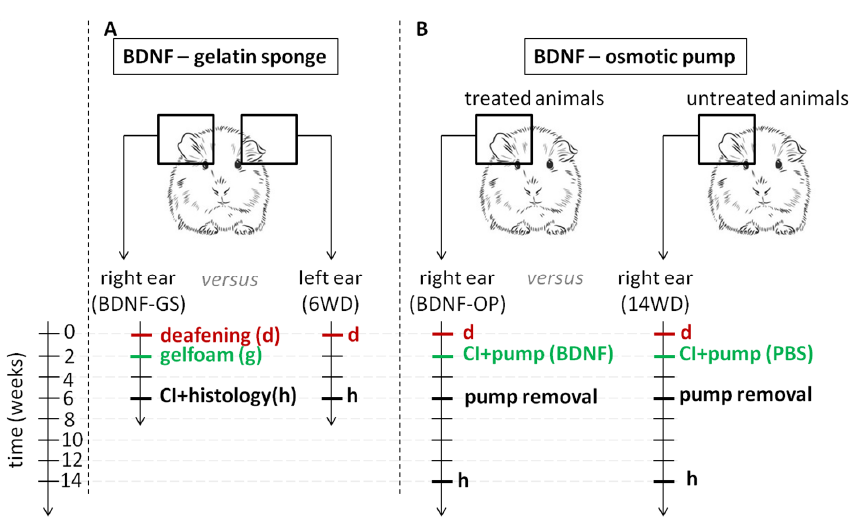
Figure 1. Schematic illustration of the experimental groups. ( A ) Study A was conducted on deafened guinea pigs which received the BDNF-gelatin sponge treatment in the right ears two weeks after deafening, while the contralateral left ear was used as internal (within-subject) negative control; animals received a cochlear implant (CI) in their right ears, six weeks after deafening for acute electrophysiological recordings, and then were euthanized and the cochleas collected for histological analysis. ( B ) Study B was conducted on deafened guinea pigs which received a CI connected to a BDNF-filled osmotic pump in the right ears two weeks after deafening; the osmotic pump was removed after four weeks and the animals were euthanized eight weeks thereafter; the right BDNF-treated ears were compared with the right ears of guinea pigs which underwent the same procedures, but with the osmotic pump filled with vehicle (PBS). For both studies, normal hearing (NH) animals without any treatments were used as baseline. d: deafening, g: gelatin sponge, CI: cochlear implant, h: histology.